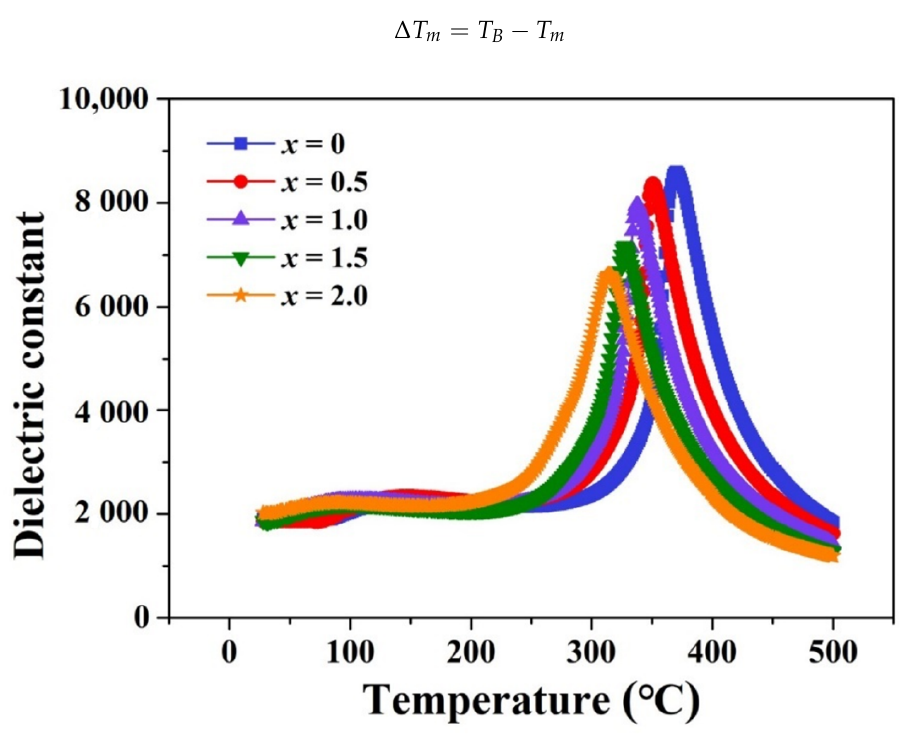
Figure 3. Temperature dependence of the dielectric constants for NKLNTS-ST- x CuO ( x = 0~2.0 mol%) ceramics measured at 100 kHz.